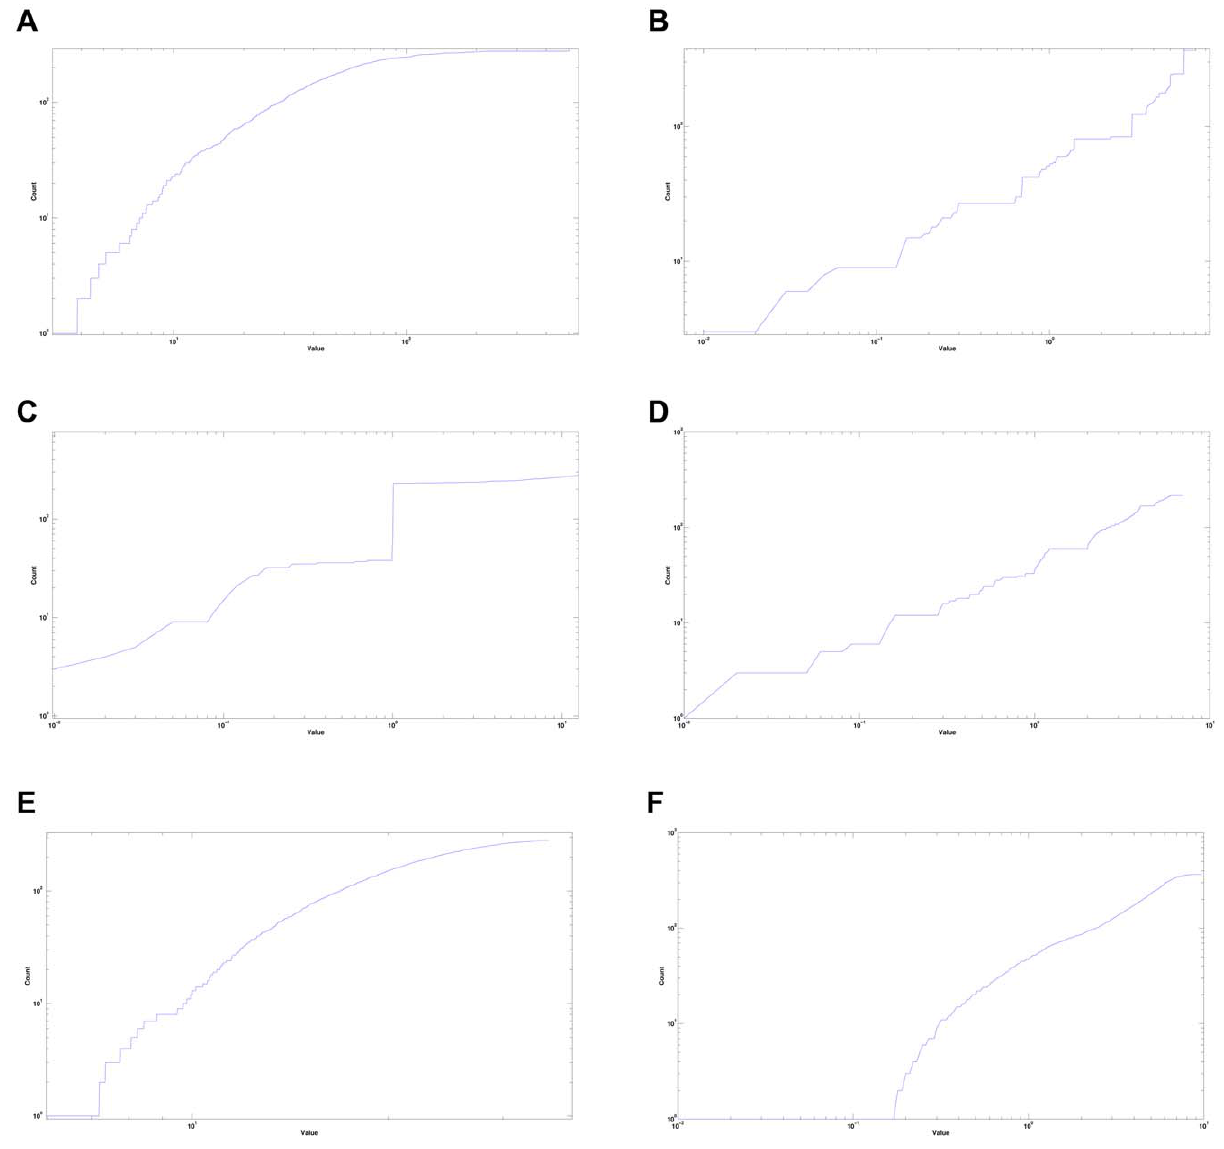
Figure 1. Weyl Ratios (a) C. elegans neural network (b) Sierpinski Gasket, Level 5 (c) Random Tree n ~ 279, m ~ 10 (d) Hexacarpet Level 3 (e) Random Network n ~ 279, p ~ 0 : 07 (f) Sierpinski Gasket Rewiring p ~ 0 : 15